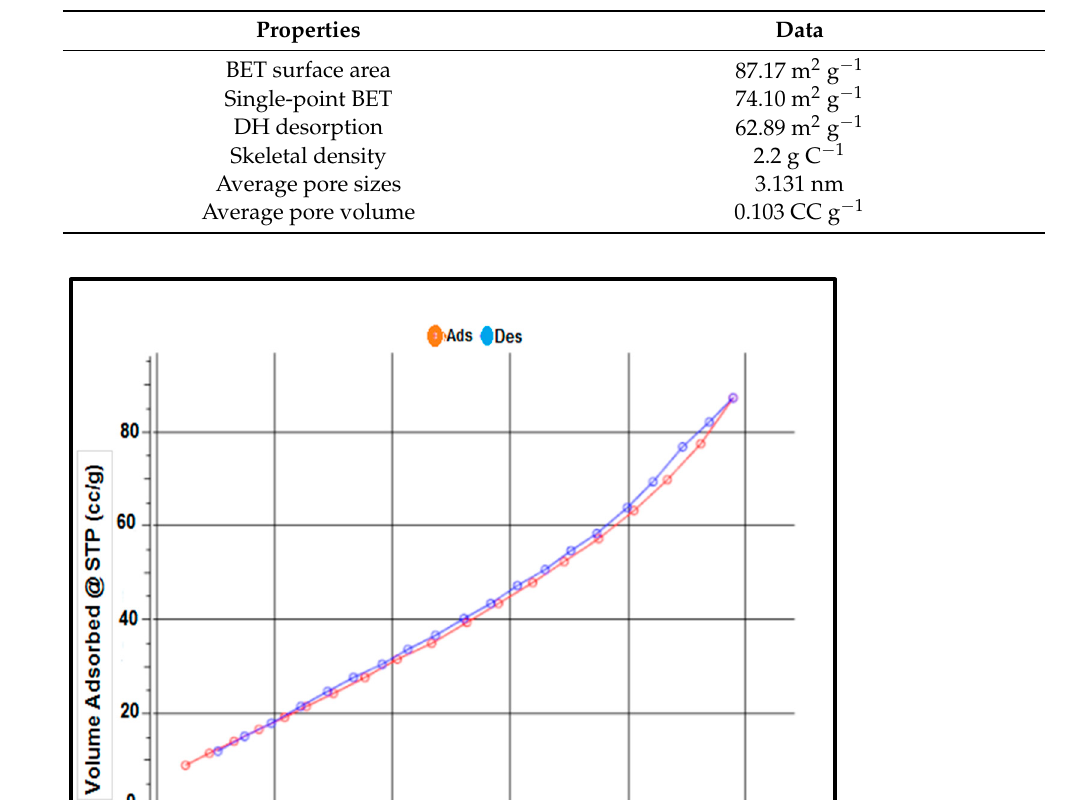
Table 1. Physical properties of S. costatum .